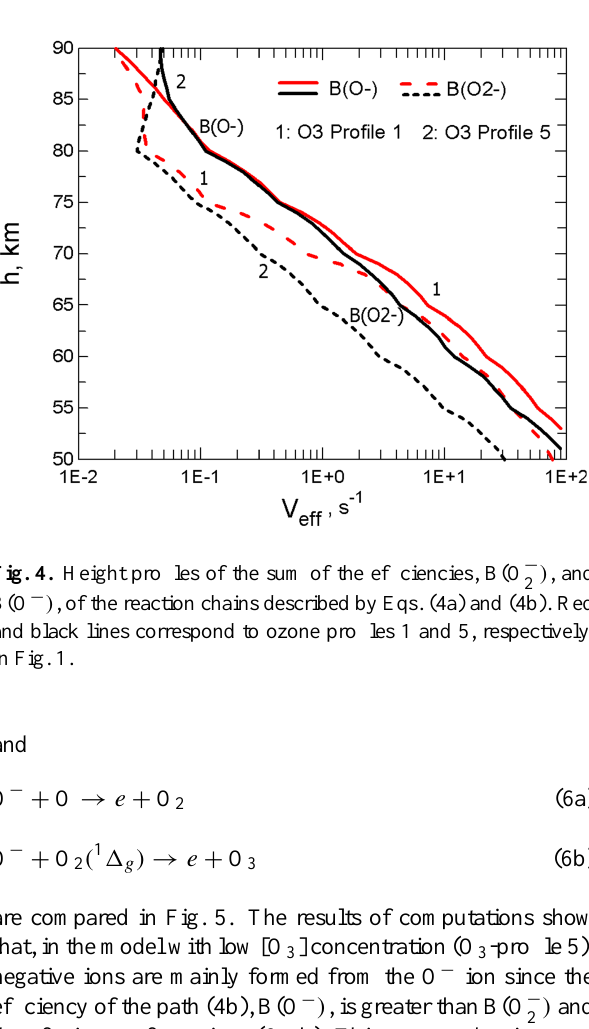
Fig. 4. Height profiles of the sum of the efficiencies, B(O − B(O − ) , of the reaction chains described by Eqs. (4a) and (4b). Red and black lines correspond to ozone profiles 1 and 5, respectively, in Fig. 1.